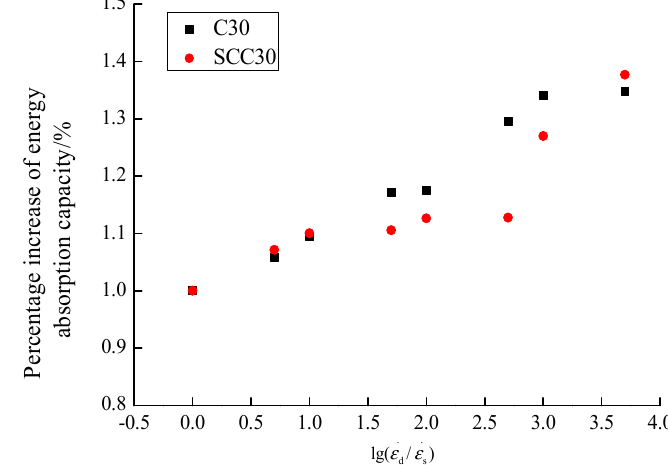
Figure 7. The influence of strain rate on the percentage increase of energy absorption capacity.